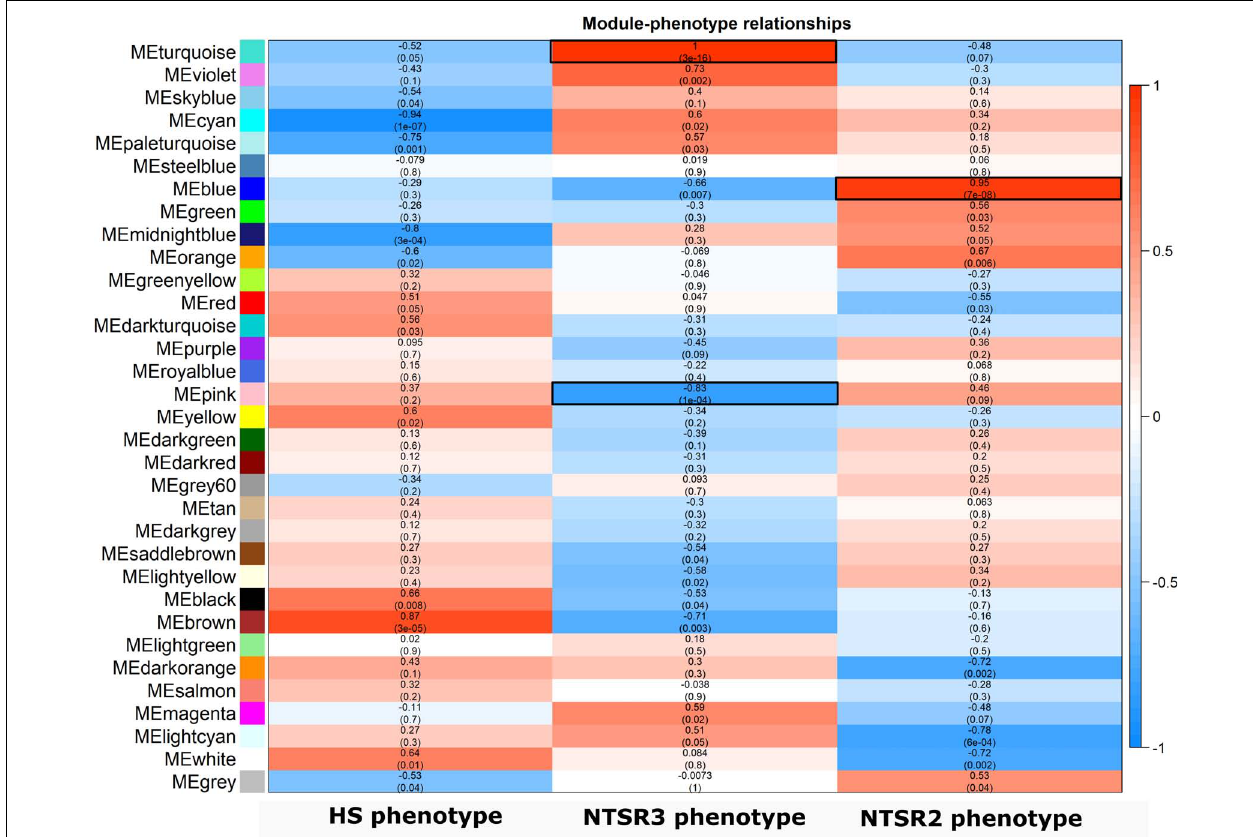
FIGURE 6 | Heatmap of the bicor correlation between the eigengenes of each WGCNA modules. Each row represents a module eigengene and each column a phenotype determined by the resistant or sensitive to the different herbicides. R -value and P -values of the bicor correlation between the eigengenes and the phenotypes are indicated in each square. In red, positive correlations; and in blue, negative correlations. HS, sensitive population; NTSR3, derived from HS and selected for resistance to fenoxaprop- P -ethyl; NTSR2, derived from HS and selected for resistance to pendimethalin; WGCNA, weighted gene co-expression network